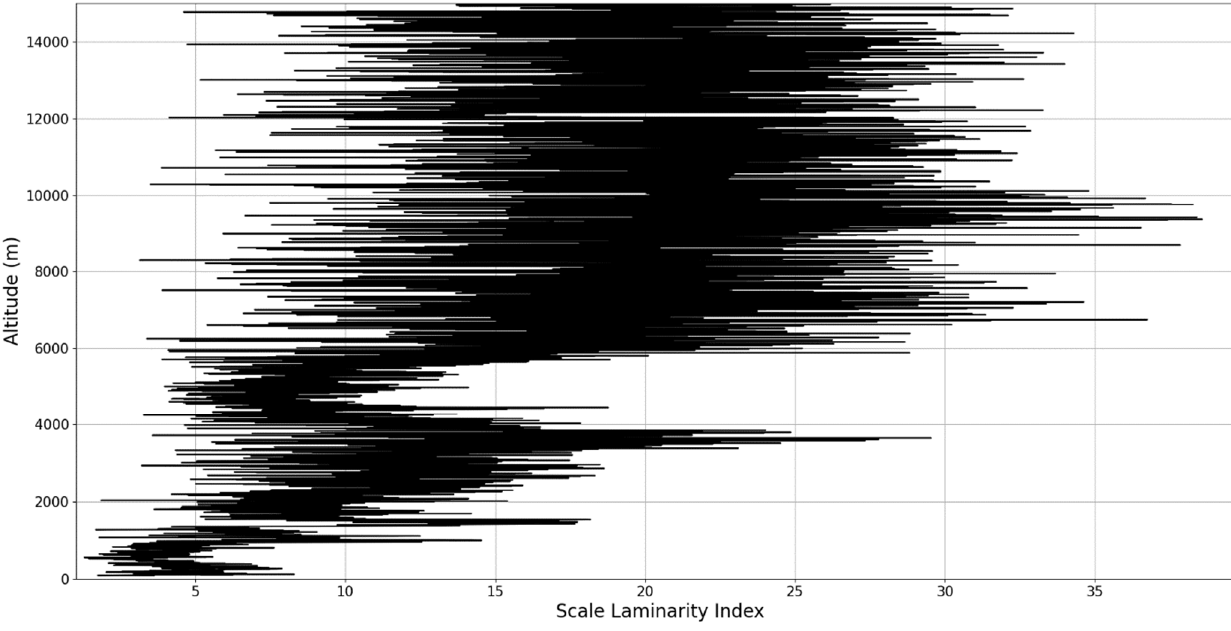
Figure 32. Scale laminarity index profile plot corresponding to point C.